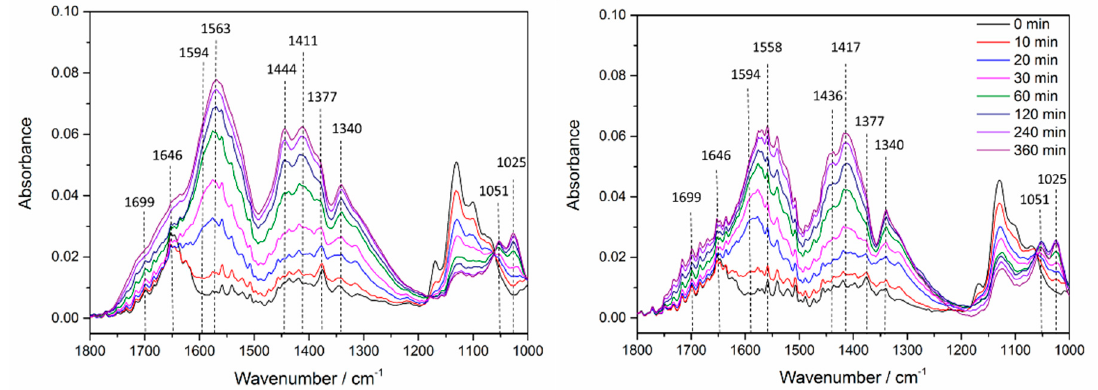
Figure 9. ATR-FTIR spectra of a TiO 2 film recorded during gaseous treatment of acetaldehyde in O 2 ( left ) and N 2 ( right ) atmosphere, upon UV-illumination, for 6 h. Table 2. Vibrational frequencies and mode assignments of the observed FTIR bands (cm − 1 ) during the acetaldehyde treatment of an anatase film, upon UV illumination.